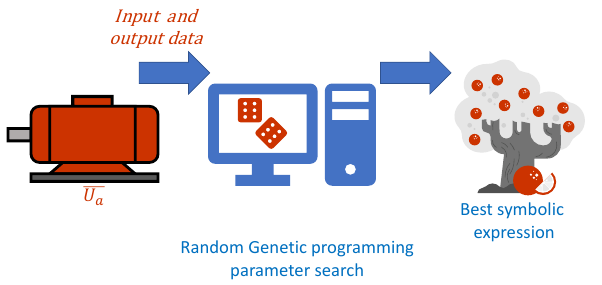
Figure 5. The dataflow of GP with random parameter search for the case of U a